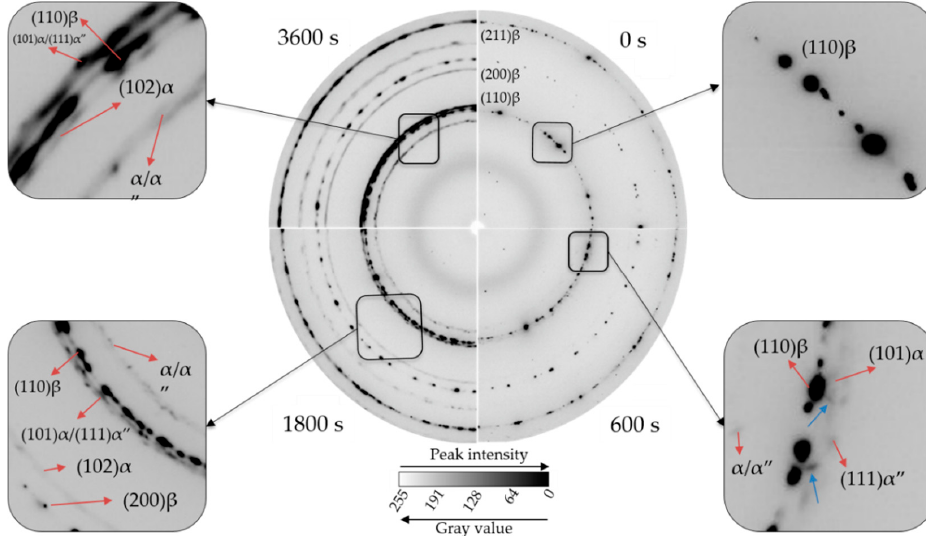
Figure 3. Representative quarters of Debye–Scherrer rings obtained during ageing for instants t = 0 s, t = 600 s, t = 1800 s, and t = 3600 s and respective phases observed, magnified 10 times in the respective boxes corresponding to each period of time. The diffuse inner ring observed corresponds to the scattering of a quartz capsule.